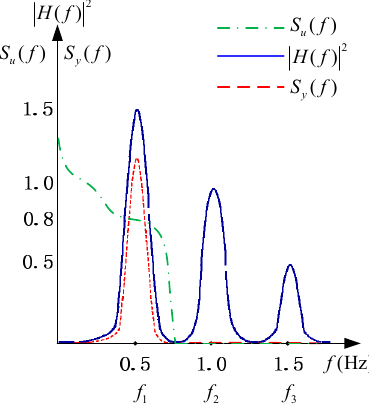
Figure 4. Principle of general forced oscillation.